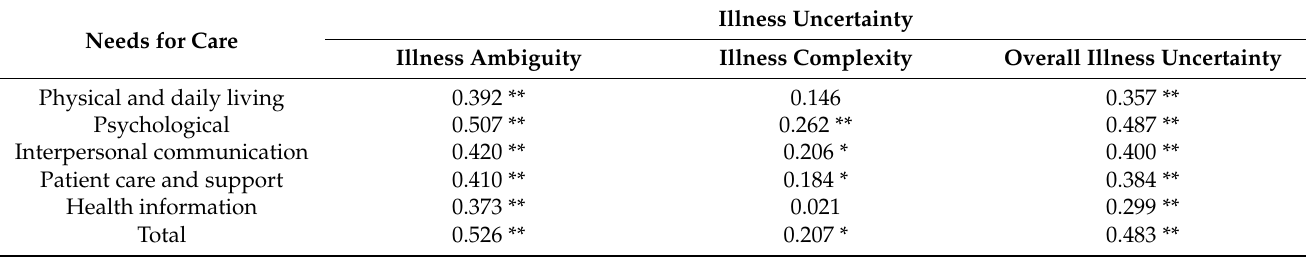
Table 5. Correlationcoefficientsbetweenpatientillnessuncertaintyandunmetcareneedsindifferentareas.